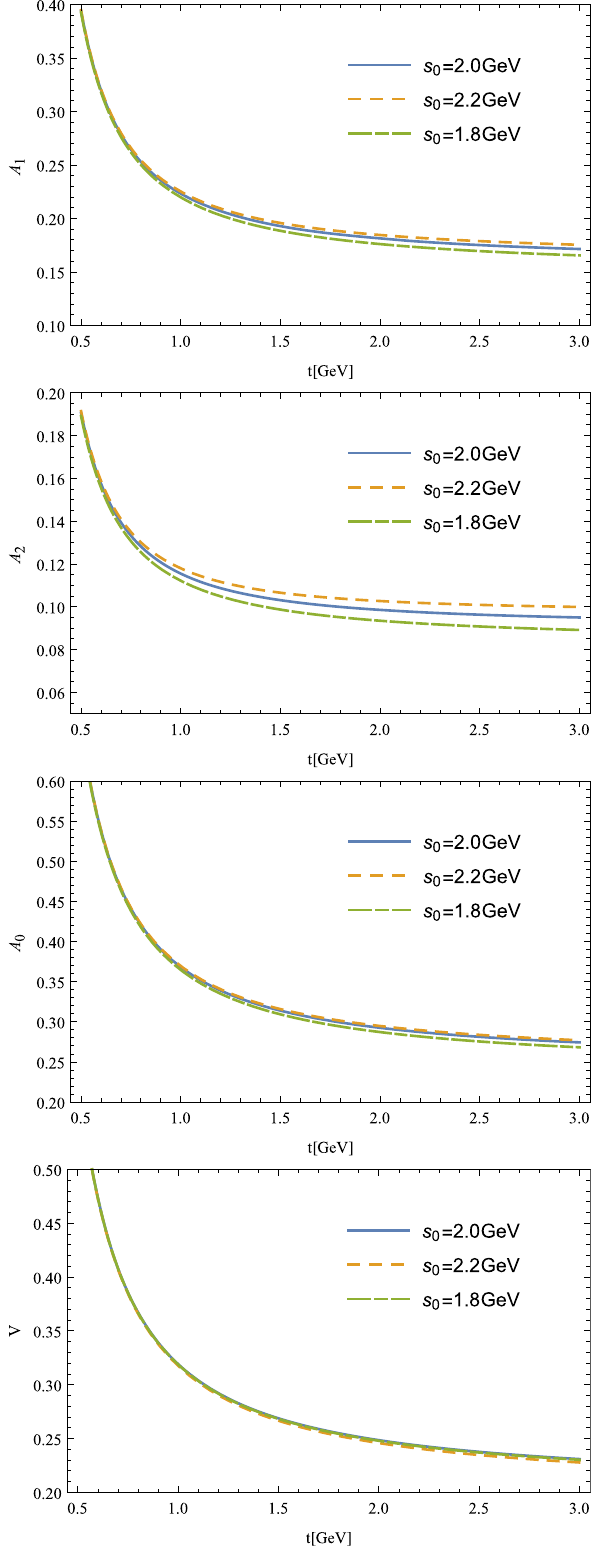
( 1430 ) form factors as functions of t for different s 2